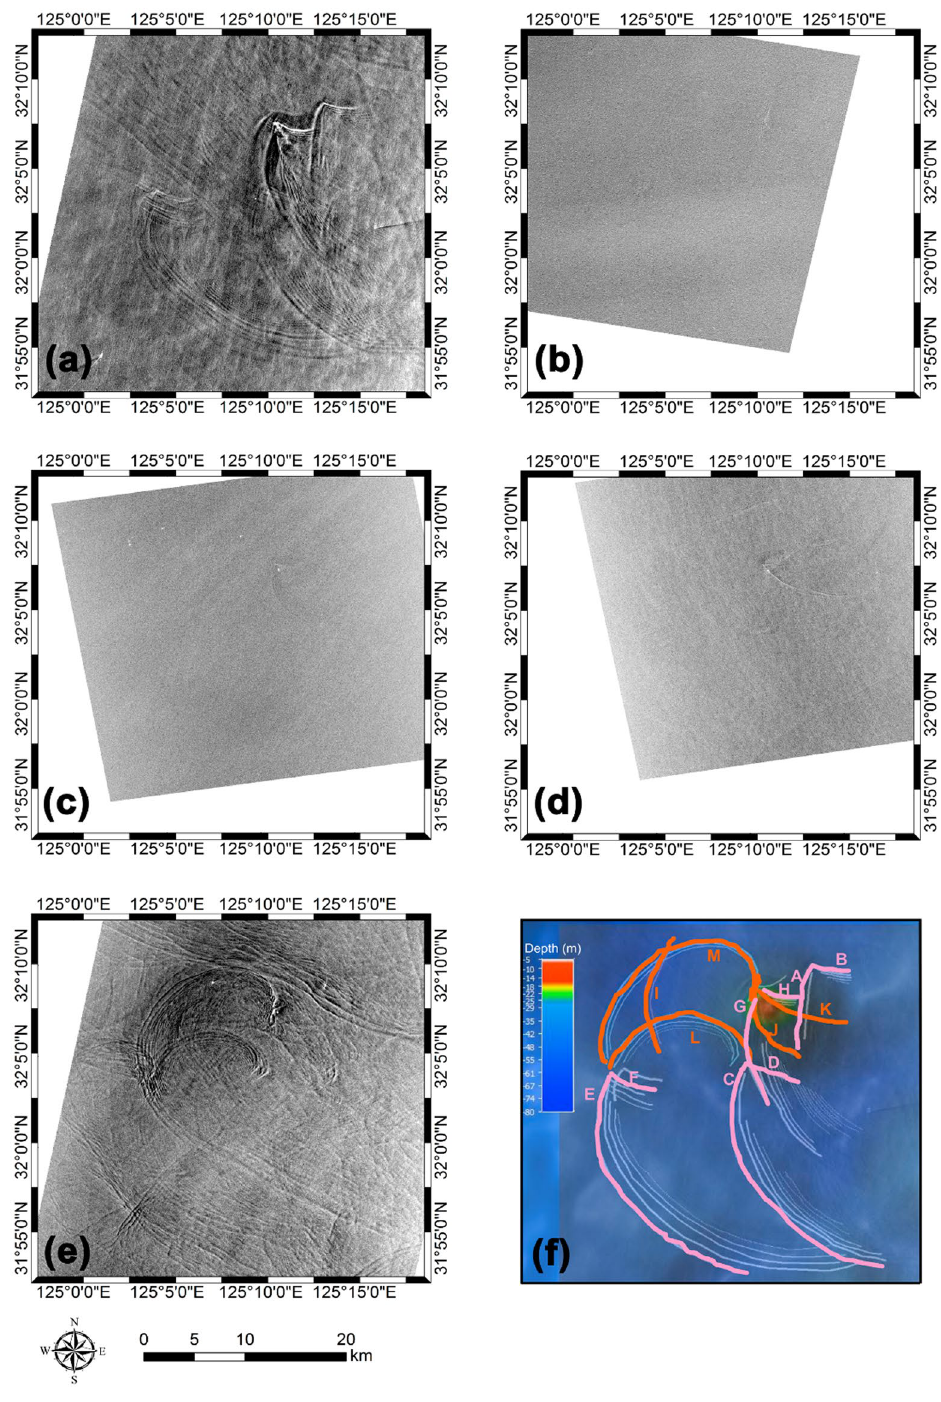
Figure 1. Synthetic aperture radar (SAR) images in the vicinity of a small topographic sill (submerged rock known as IEODO, 32°N 7.38 ′ , 125°E 10.95 ′ ) in the northern East China Sea. SAR images taken on ( a ) 21:45:30 UTC September 10, 2014, ( b ) 09:43:54 UTC May 28, 2015, ( c ) 21:38:07 UTC June 3, 2015, ( d ) 21:31:17 UTC June 5, 2015, ( e ) 21:45:31 UTC June 12, 2015, and ( f ) bottom topography around the sill (color scale in the top- left), superimposed with a surface manifestation of wave fronts where the increased sea surface roughness is found in association with convergences of near-surface currents induced by internal waves (from ‘A’ to ‘H’ in 2014; pink, from ‘I’ to ‘M’ in 2015; orange) with an indication of directional measure of distance (distance from a moving local origin as a function of an angle difference θ in degree rotated counterclockwise from the